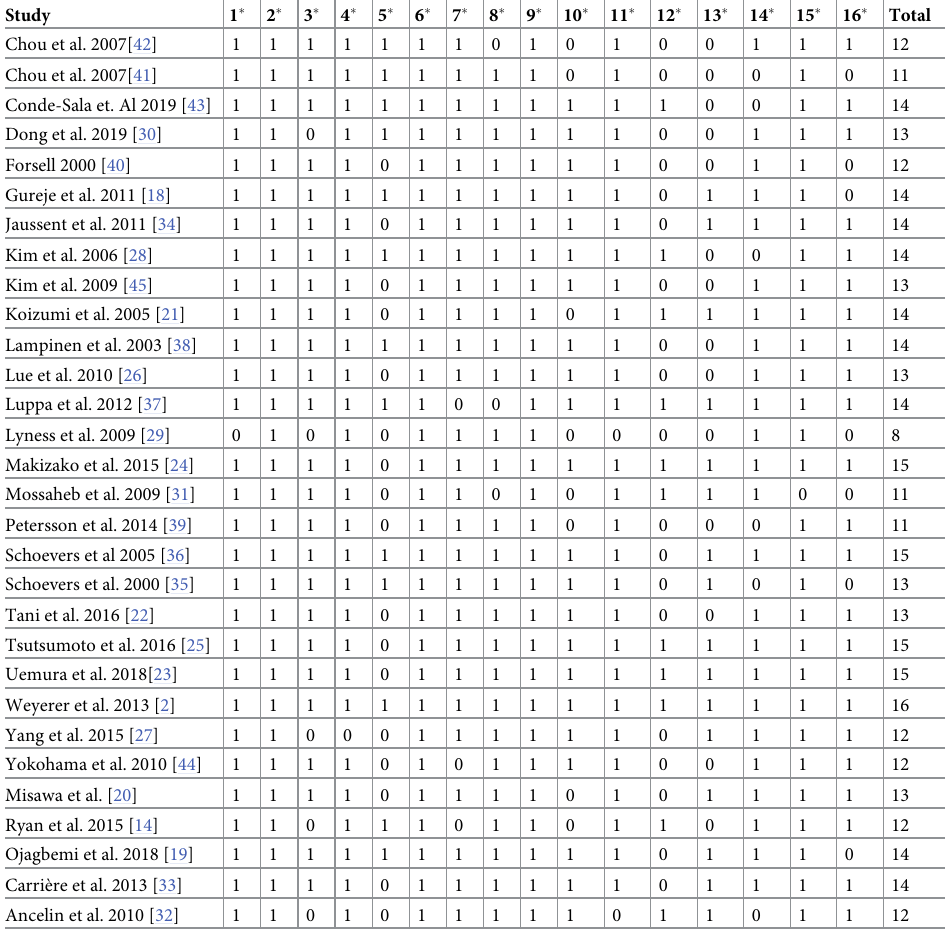
Table 4. Score of studies on each criterium for quality assessment score.